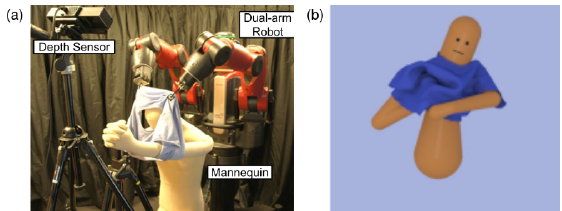
Figure 7. Dressing Tasks: ( a ) Assistive dressing by Koganti et al. (2017) [300] and ( b ) self-dressing by Clegg et al. (2018) [32]. Figures reproduced with